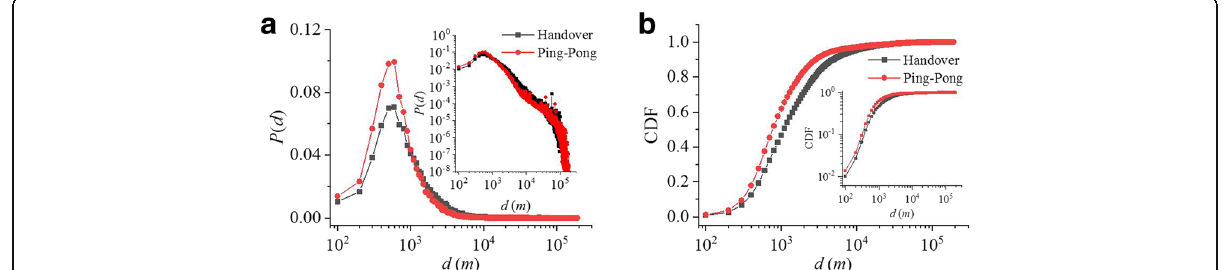
Fig. 3 Distance distribution of handover. a Distance distribution. b Cumulative